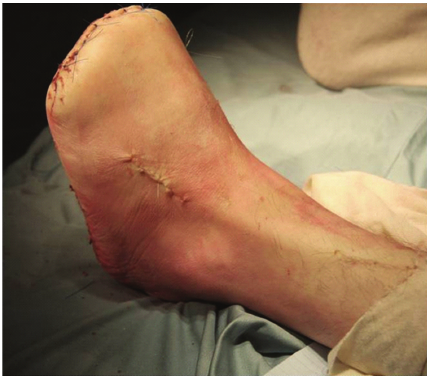
Figure 3: Not the visible tibialis anterior tendon routed laterally following a